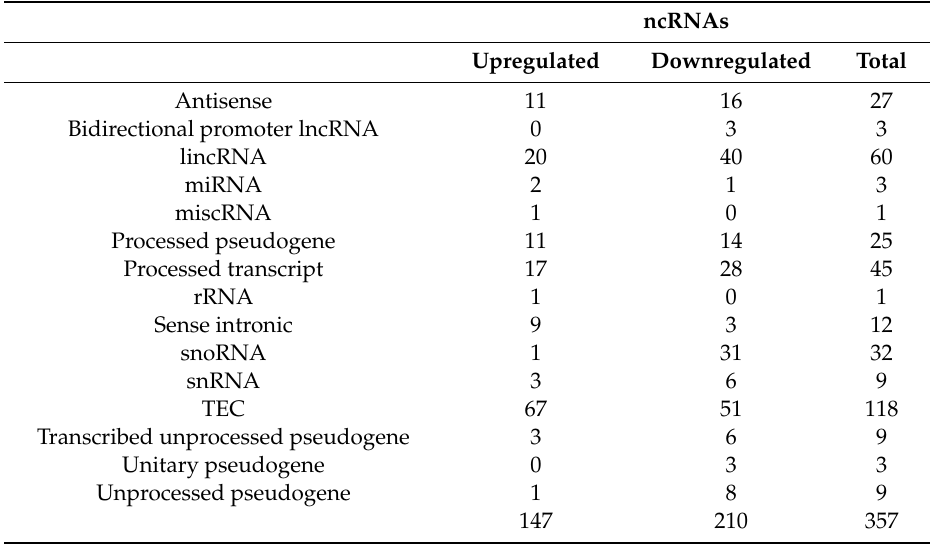
Table 3. Number and biotype of deregulated noncoding